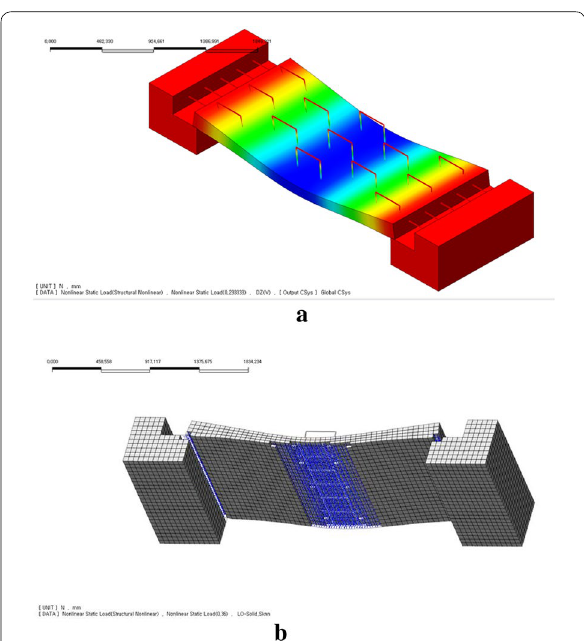
Fig. 19 FEM analysis results (AD). a Contour of FEM analysis (AD). b Crack pattern of FEM analysis (AD).